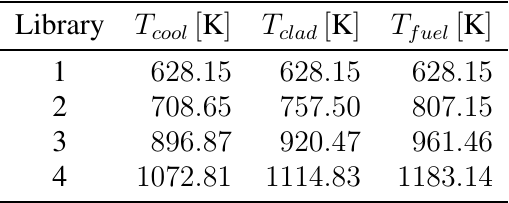
Table 1: Temperatures Selected for Cross Section